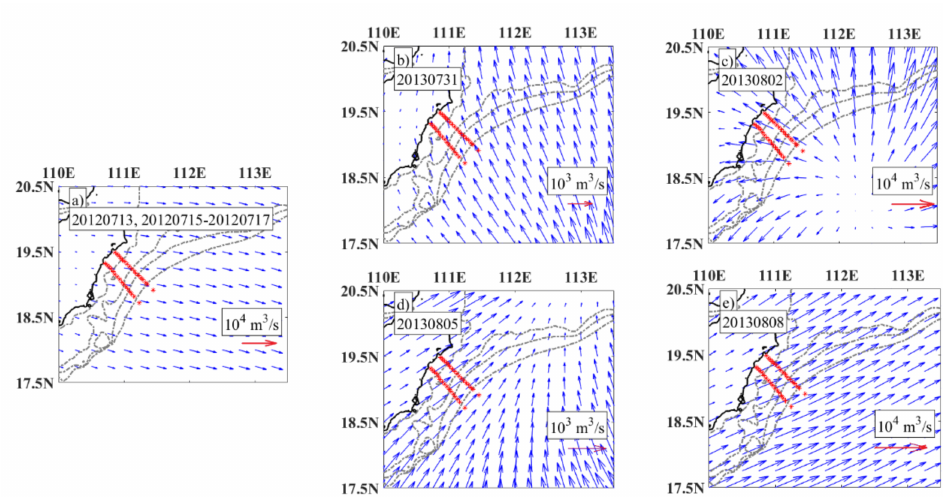
Figure 12. The Ekman transport in the case without the typhoon on 13 and 15–17 July 2012 ( a ), before the typhoon on 31 July 2013 ( b ), during the typhoon on 2 August 2013 ( c ), and after the typhoon on 5 ( d ) and 8 August 2013 ( e ). Red starts represent observation stations in the two sections H and F. Gray lines represent iso-baths of 50, 100, 150, and 200 m.